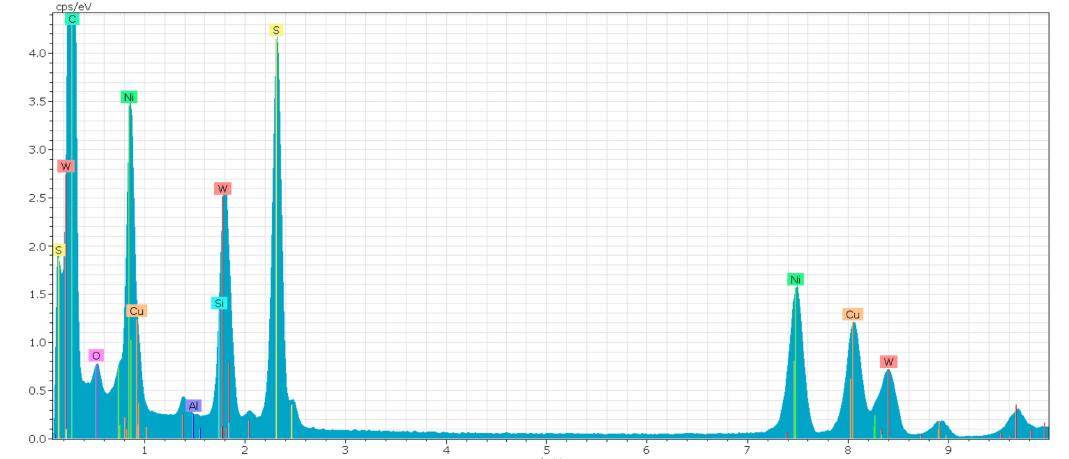
Figure A1. EDX spectrum of catalyst NiWS-HY